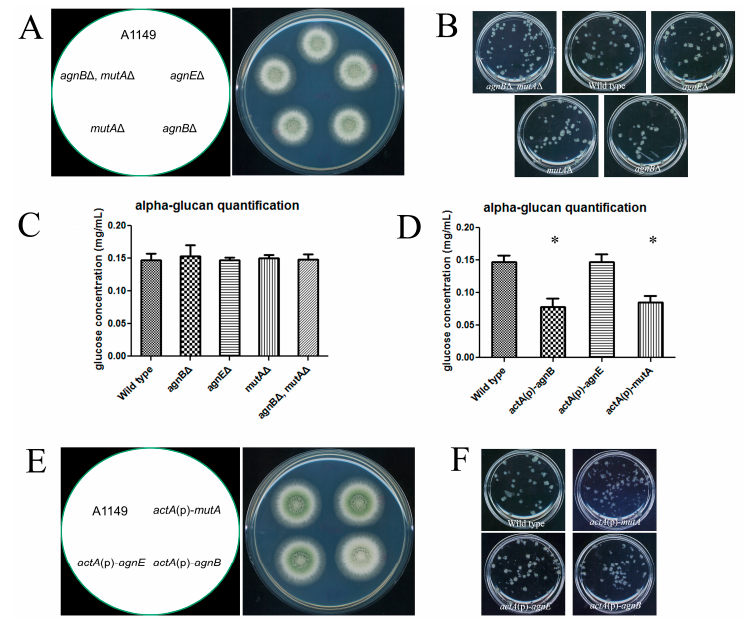
Figure 3. AgnB and MutA are functional α -glucanases. ( A ) Freshly harvested conidia (10 5 ) of each strain were inoculated on complete medium and the plates were incubated at 30 °C for 48 h. All constructed strains showed the wild-type colony phenotype on solid medium; ( B ) freshly harvested conidia (5 × 10 7 ) were inoculated in a flask with 20 mL complete medium, then the flask was incubated at 30 °C, 150 rpm overnight. All strains behaved the same as the wild-type; ( C , D ) spores of the indicated strain (2 × 10 7 ) were inoculated in 100 mL complete medium. Samples were grown in flasks at 30 °C with 150 rpm for 24 h. α -glucan was extracted from 1 mg of dry cell wall, and then digested to glucose and quantified using an anthrone assay [24]. Results represent the mean of three independent quantification tests with duplicates each time ± standard deviation. The data for each strain were compared with the wild-type (column 1) individually by a Mann Whitney U test. Significant difference ( p < 0.05) was indicated by asterisks; ( E ) conidia of each strain were prepared and inoculated as in ( A ). Only actA (p)- agnB showed pigment deficiency; and ( F ) all strains behaved the same as the wild-type in shaken liquid medium. Growth condition was the same as described in ( B ).